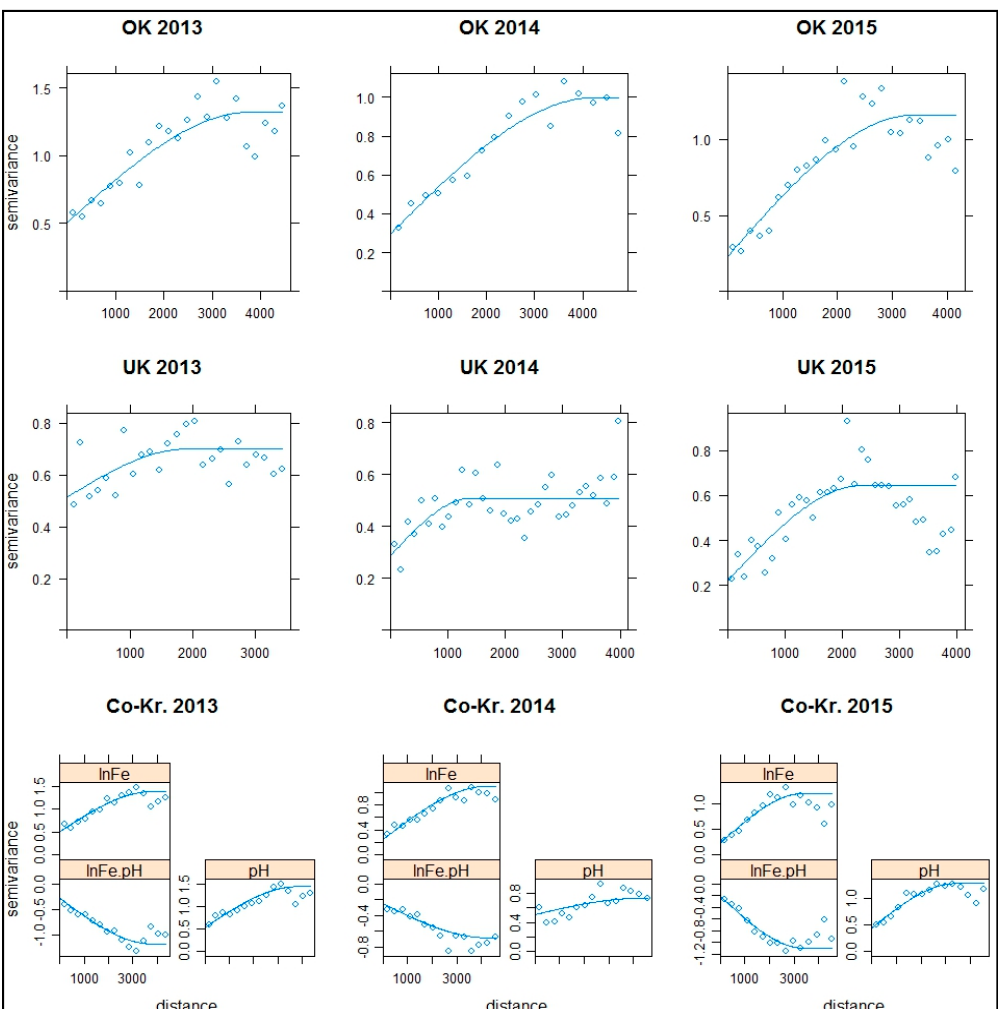
Figure 7. Experimental semivariograms and their fitted models of ln(Fe) for every interpolation method each year. Regarding Co-Kriging interpolation (last line of the semivariograms), apart from the Ordinary Kriging (OK) ln(Fe), the OK pH semivariogram and the ln(Fe)-pH cross-semivariogram are also presented for each year.